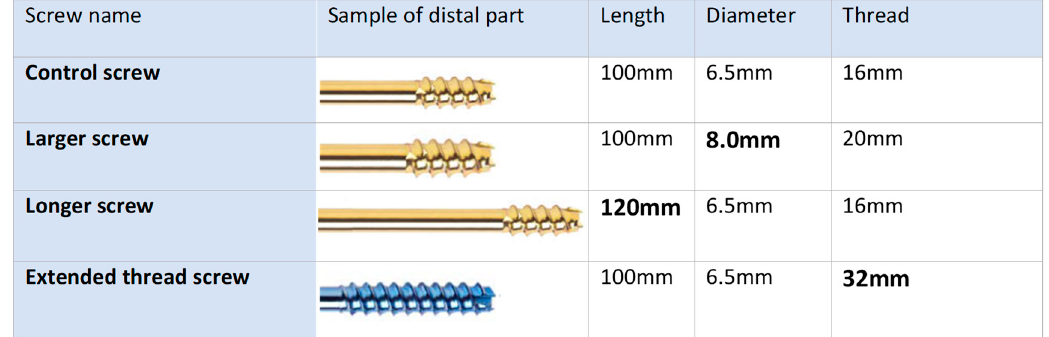
Figure 1. Characteristics of the screws considered in the current study.